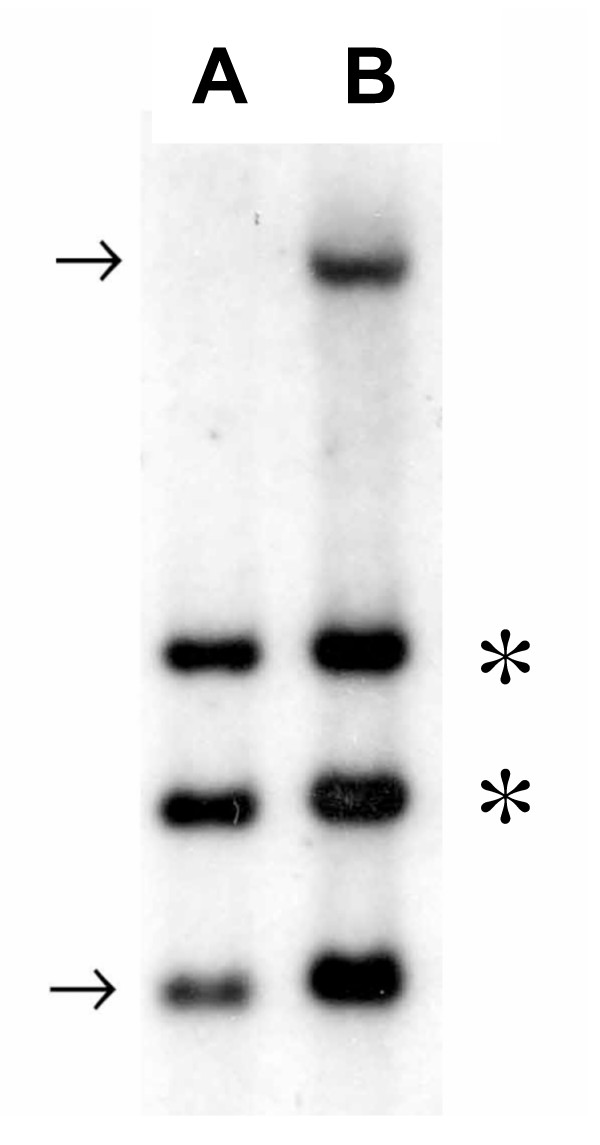
Southern blot analysis of the immunoglobulin heavy chain (IgH) locus in DNA from (A) LCL8664 cell line and (B) the original tumor mass from which LCL8664 cell line was derived. DNA (5 μg) was digested with Sacl and hybridized to a probe from the human IgH locus, 3' to the JH region. The arrows indicate the fragments generated from the locus in germline organization. The asterisks indicate the clonal rearrangement of the IgH locus. DNA from the tumor mass contains a large germline fragment not present in the cell line, indicative of contamination of the original necropsy sample with non-neoplastic tissue.